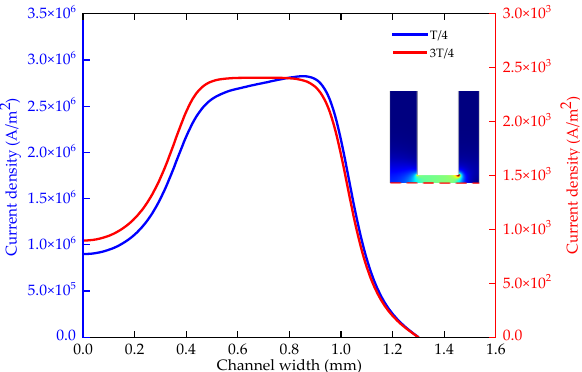
Figure 7. The current density of the pulse ECM.